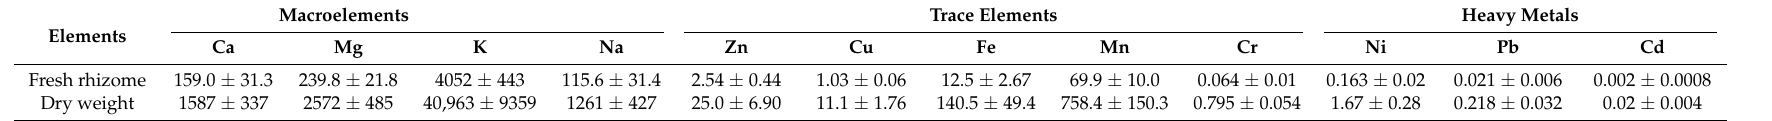
Table 3. The average content of elements in ginger cultivated in ecological plantations on Shikoku Island (Japan)